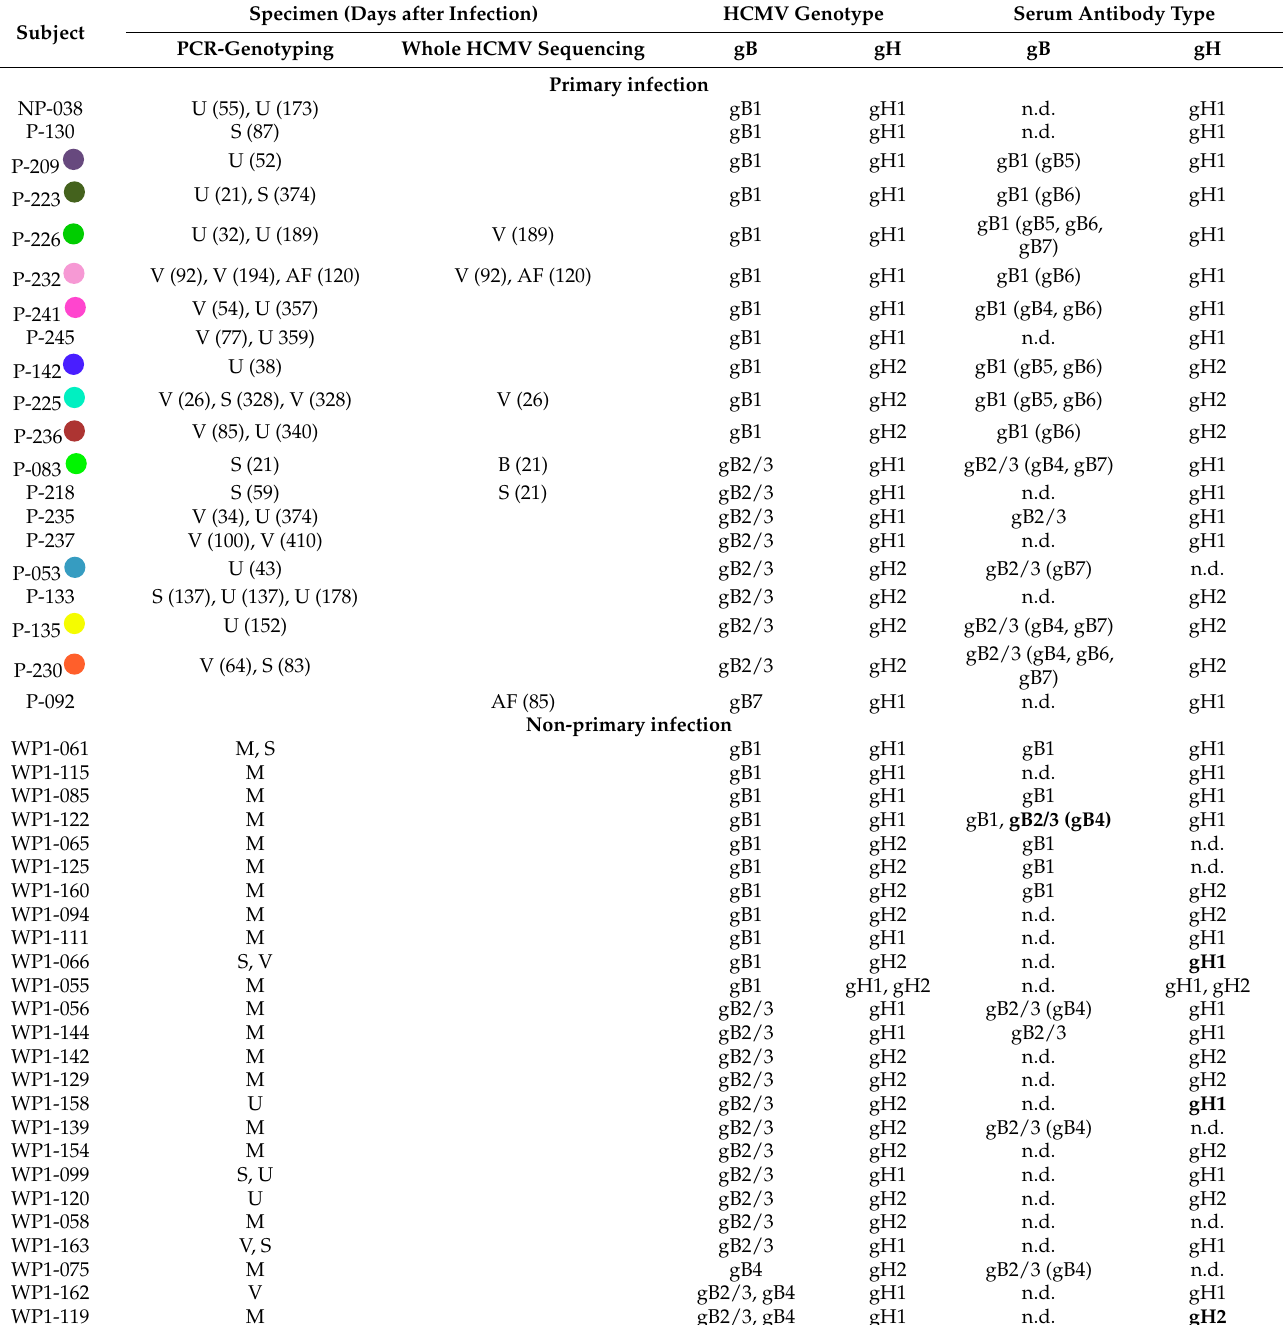
Table 1. gB and gH genotypes and serum antibody types of 20 subjects with primary infection and 25 women with non-primary infection.